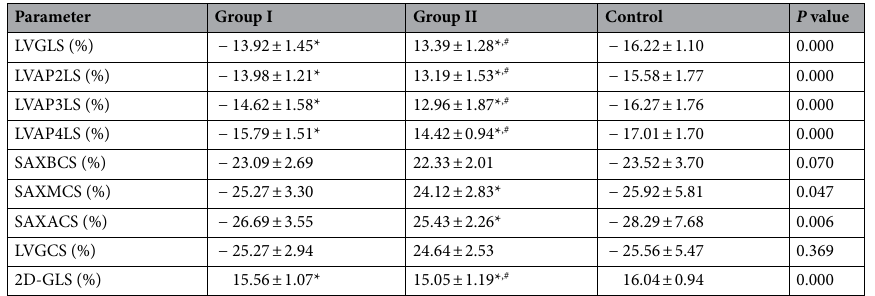
Parameter Group I Group II